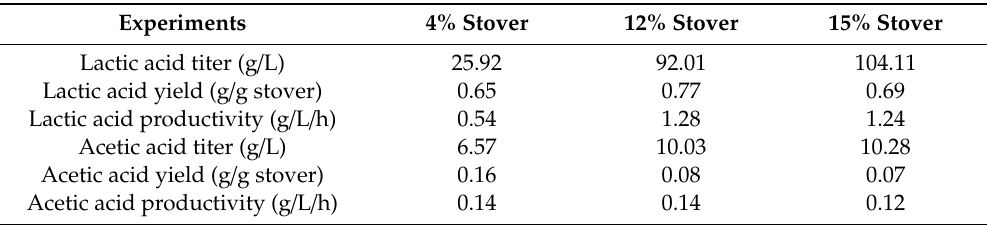
Table 2. Summary of lactic acid fermentation by P. acidilactici PA204 using NaOH-pretreated and washed corn stover with washing as the carbon source. 4% stover: Simultaneous saccharification